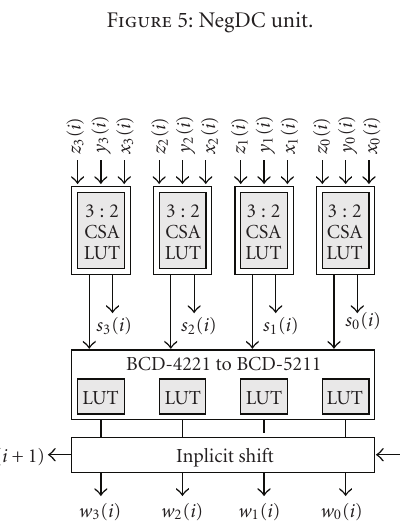
Figure 5: NegDC unit.